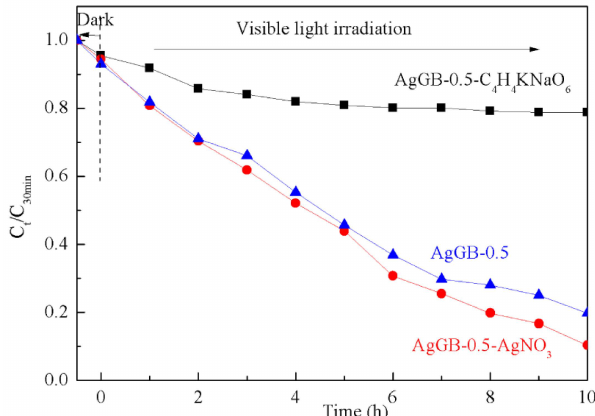
Figure 9. Photocatalytic degradation of RhB in AgGB-0.5 after addition of an electron-trapping agent or a hole-trapping agent.